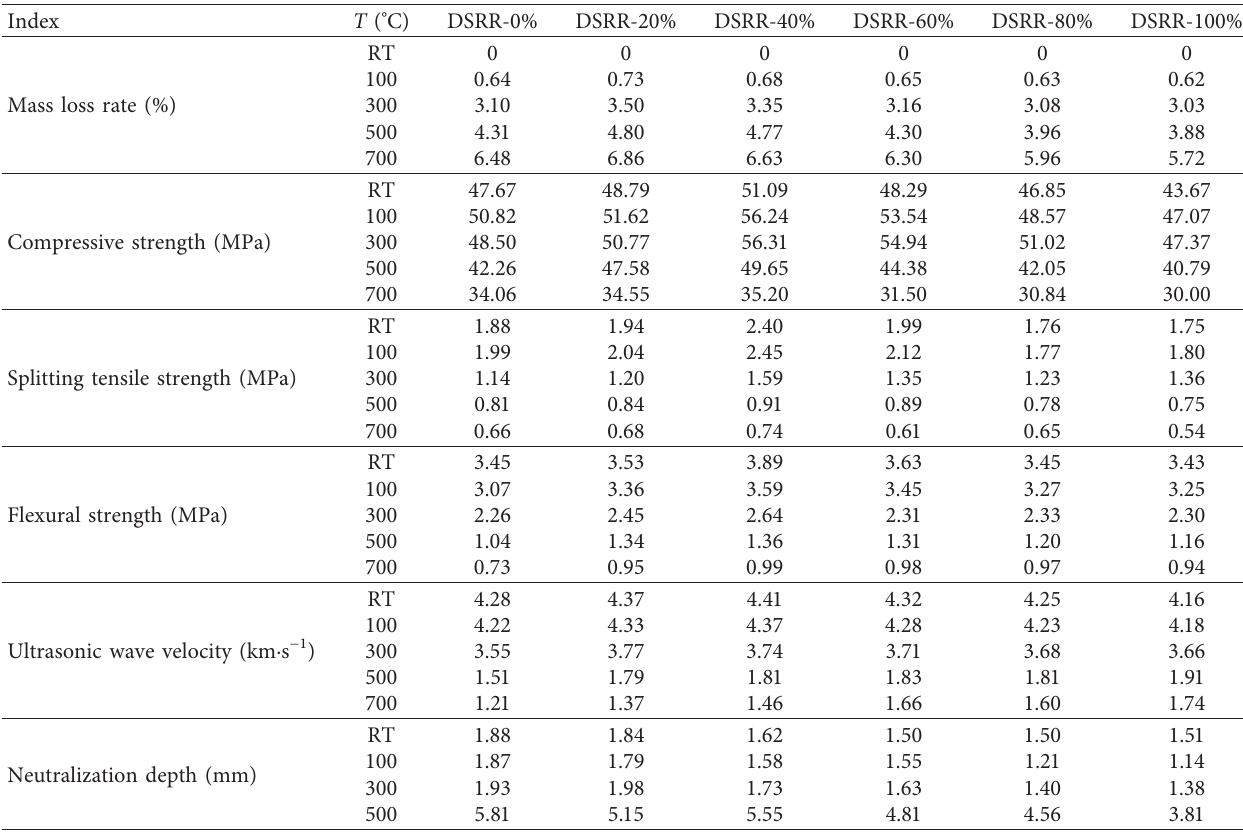
Table 6: Experimental results of DSC after elevated temperature.